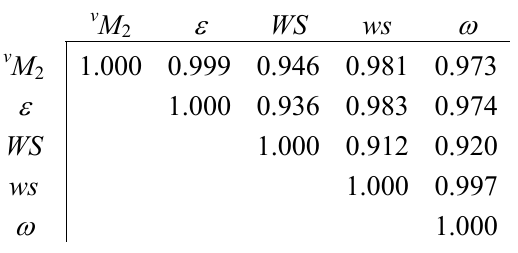
Table 2 . The intercorrelation